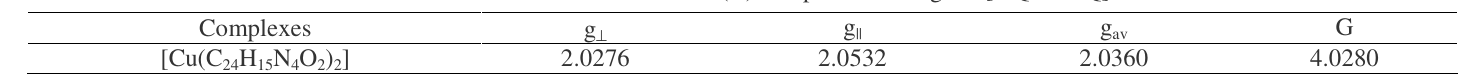
Table 4. ESR data of the Cu(II) complex of the ligand